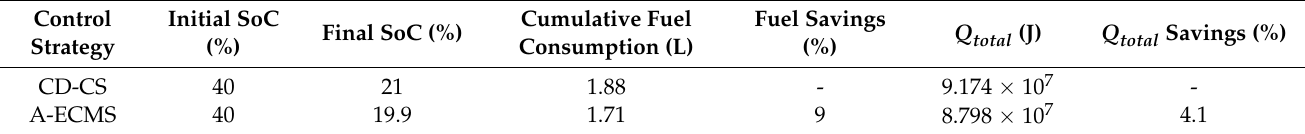
Figure 15. Vehicle performance comparison for real-world cycles. Table 6. Summary of vehicle performance comparison for real-world cycles.